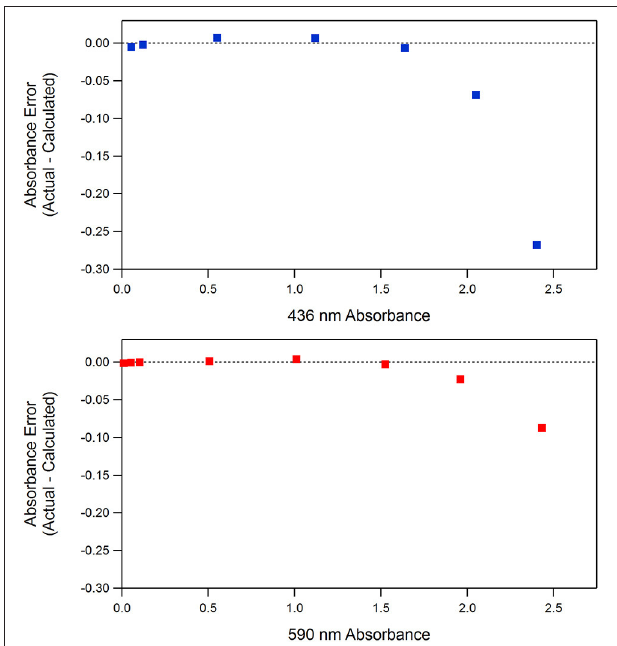
FIGURE 3 | SAMI-pH seawater pH and temperature time-series collected in the surface ocean off the Oregon coast (44.6 ◦ N, 124.3 ◦ W) in collaboration with Burke Hales (OSU) (A,B) . Tris seawater buffer was measured every 5 days during the deployment (black diamonds in A ). Tris pH varies due to its strong temperature dependence and is higher at colder temperatures. The difference between the measured and calculated tris pH is shown in (C) ( − 0.001 ± 0.003 pH units, n =